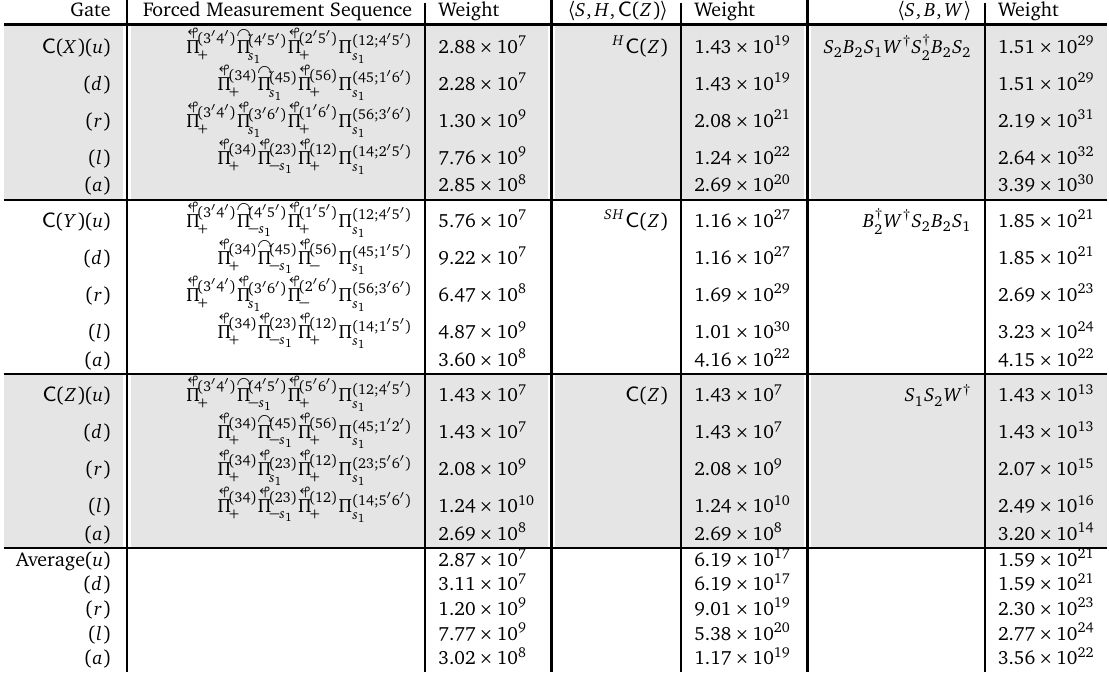
Table 16: Minimal difficulty weight measurement sequences for controlled-Pauli two-qubit gates when using forced-measurement methods. The labels ( u ) , ( d ) , ( r ) , and ( l ) indicates that for a hexon acting as the control qubit of the C ( P ) gate, the corresponding target qubit is the nearest neighbor hexon in the up, down, right, and left direction, respectively. Notice that the choice of control and target qubit is arbitrary for C ( Z ) , so ( u ) and ( d ) are related by symmetry, as are ( r ) , and ( l ) . The average difficulty weight of the four directions is labeled by ( a ) . For com- parison, we also present the corresponding realization of the gates formed from the generating gate sets 〈 S , H , C ( Z ) 〉 and 〈 S , B , W 〉 . A C ( Z ) = A conjugation of C ( Z ) by A on the target